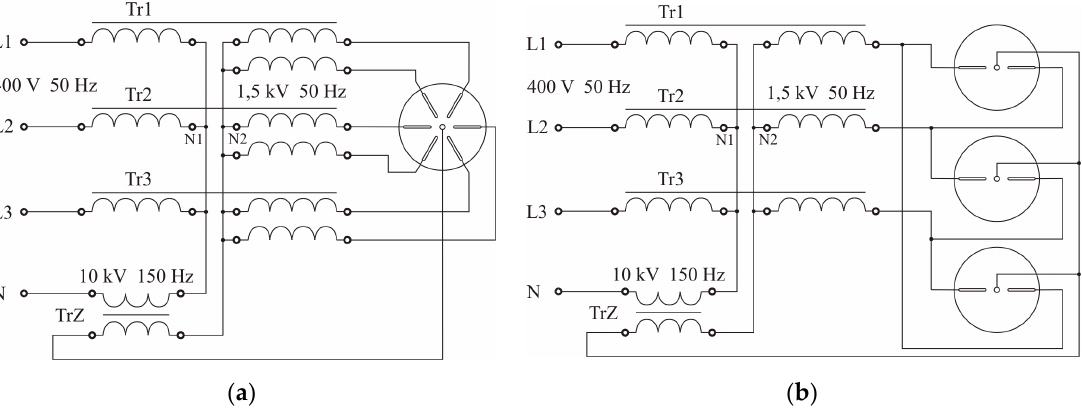
Figure 5. ( a ) IPSS for six electrode; ( b ) nine electrode GAD reactor (TrZ — ignition transformer) [5], [43].